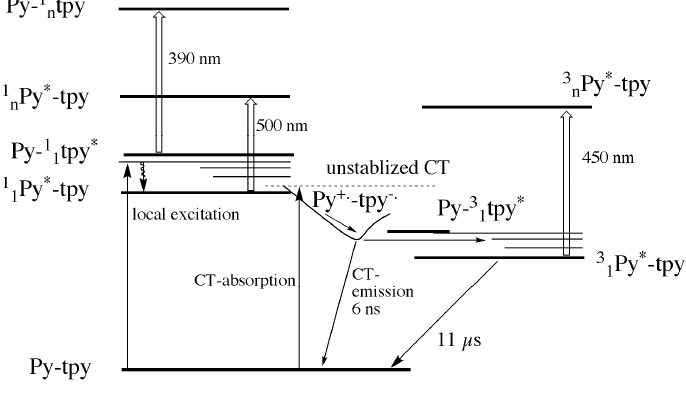
Scheme 2. Schematic representation of the deactivation pathways. in presence of the electron transfer process, of Py-tpy (generalization of a pyrene-terpyridyl system). Excited state localization, absorption and multiplicity are also indicated: 3 triplet state of Pyrene, with subscript n indicating higher lying